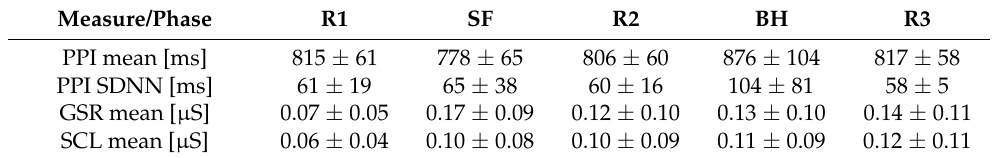
Table 1. Results of time domain PRV and GSR parameters (expressed as mean value ± standard deviation). Measure/Phase